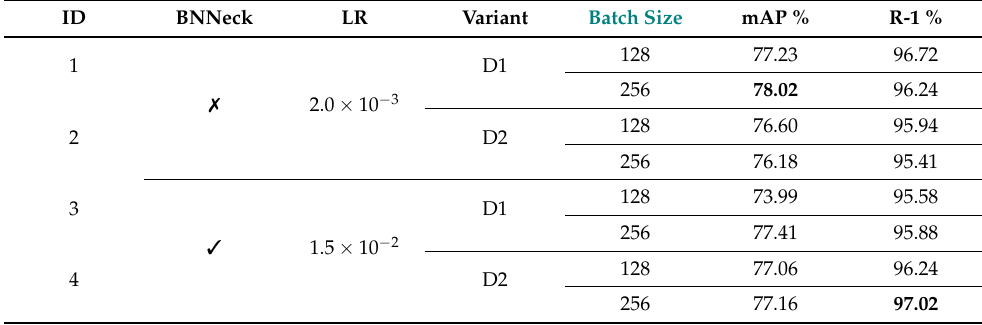
Table 12. Performance of the D1 and D2 models using different batch sizes. ID BNNeck